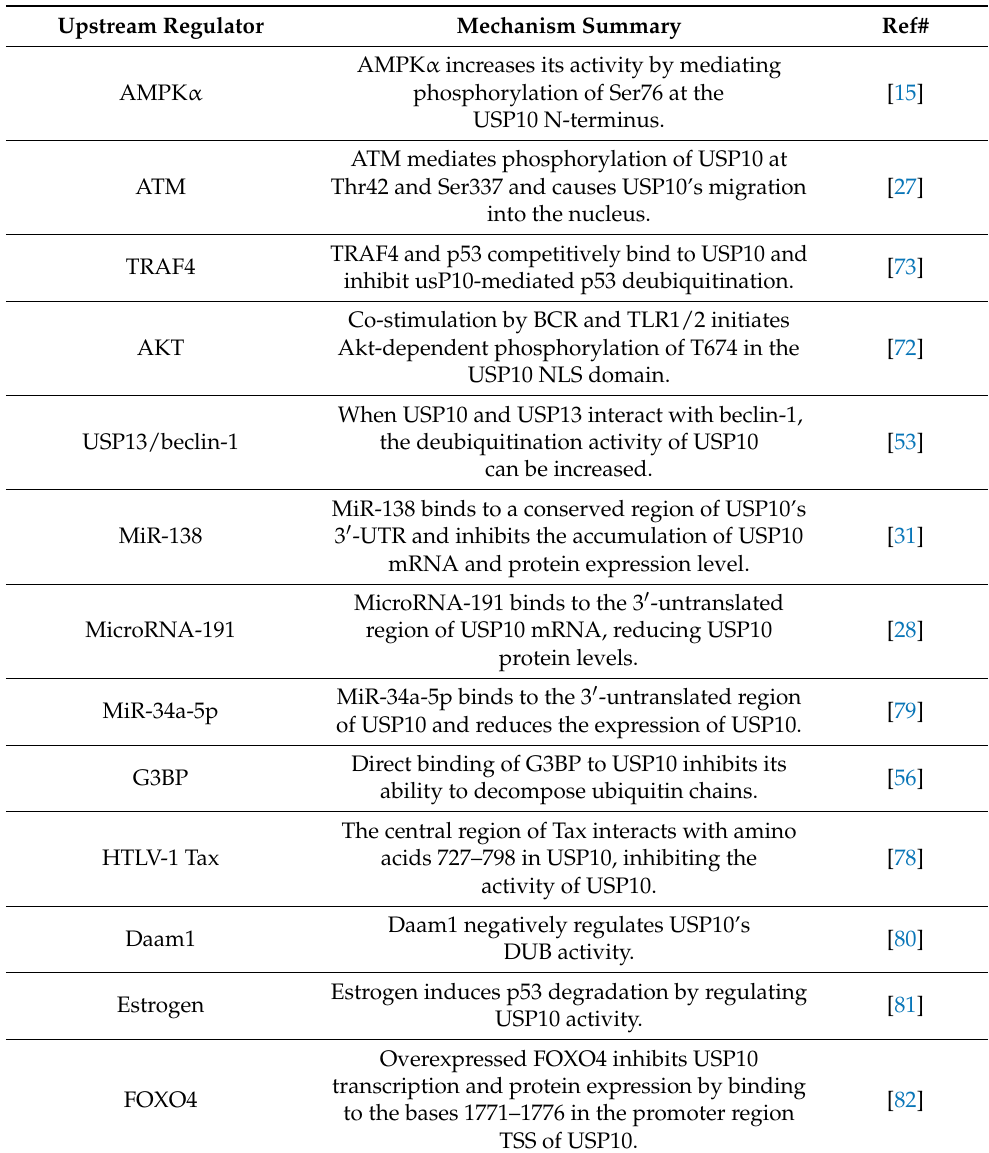
Table 2. Summary of the identified forms of regulation for